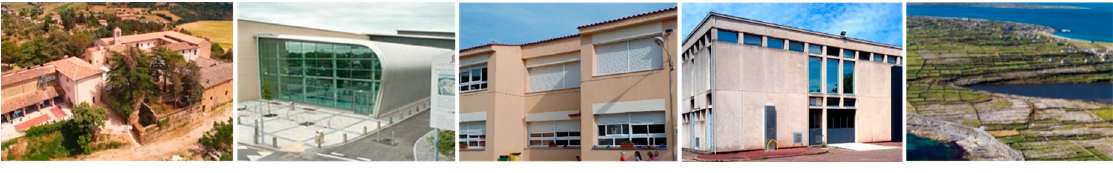
Figure 3. GEOFIT